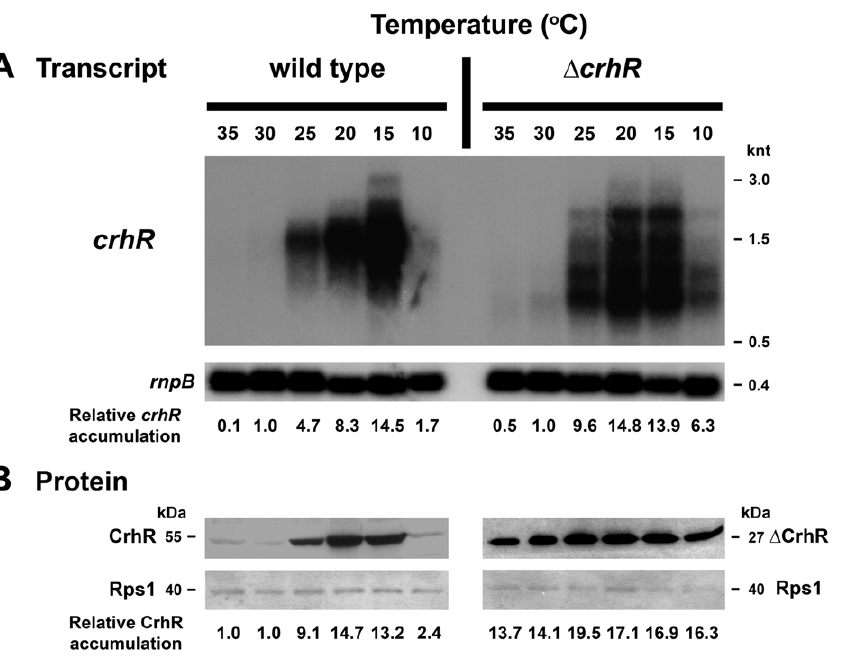
Figure 6. Temperature gradient of crhR expression. Wild type and D crhR Synechocystis were grown to mid-log phase at 30 u C and divided into 6 aliquots, each of which was incubated at the indicated temperature for 1 h and samples were harvested for RNA and protein extraction. ( A ) Total RNA on a northern blot was probed with a 93 bp Hinc II- Sac II internal fragment of crhR , stripped and probed with the Synechocystis rnpB gene as a control for RNA loading. crhR transcript levels were quantified at each temperature as described in Methods S1 and the fold change in crhR accumulation compared to the abundance in illuminated, wild type cells grown at 30 u C (set to 1.0) is provided below each lane. Ethidium bromide staining of the RNA present on the Northern blot indicates that essentially equal quantities of RNA were loaded in each lane (Figure S1). ( B ) Western blots were probed with anti-CrhR antiserum and subsequently probed with antibodies against E. coli Rps1 as a control for protein loading. Protein levels were quantified at each temperature and the fold change in CrhR or D CrhR compared to the abundance in illuminated, wild type cells grown at 30 u C (set to 1.0) is provided below each lane, as described in Methods S1.